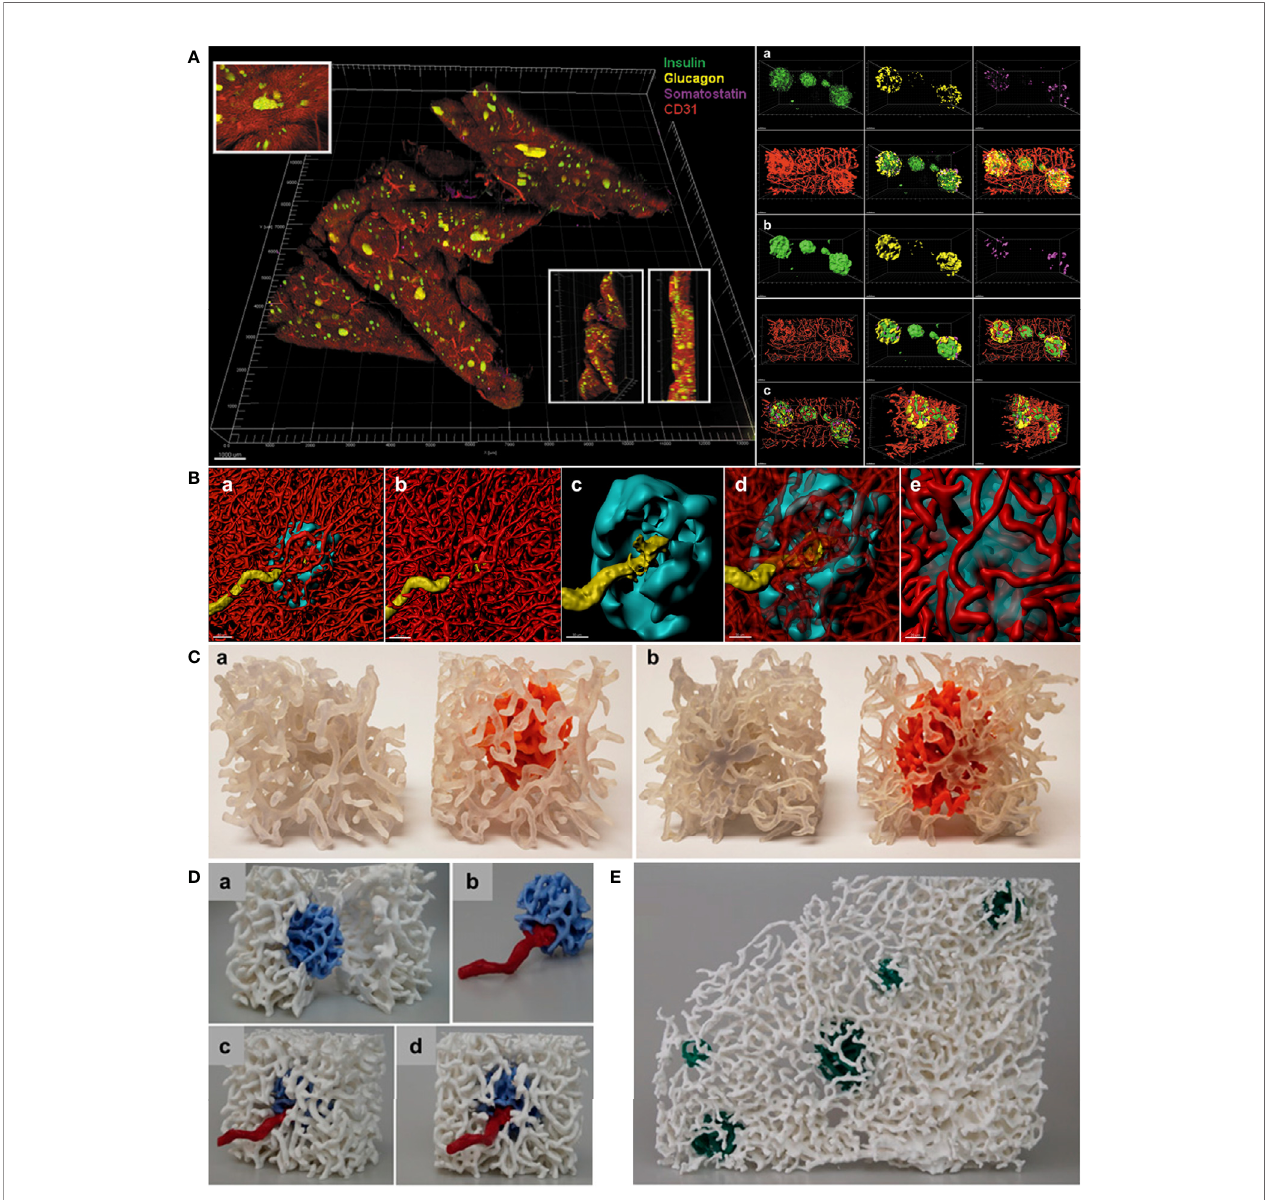
FIGURE 2 | In situ approach to study the capillary network. (A) Left . Full scan of a 600 µm pancreatic slice immunostained for insulin (green), glucagon (yellow), somatostatin (magenta) and CD31 (red). Three insets for detailed islet resolution and displaying depth with different angles. Scale bar: 1000 µm. Right . a. Cluster of islets in the sample with individual fl uorescent channel images and merged ones. b. Same cluster of islets converted to a computer-generated surface rendering with multiple angles displayed for 3D viewing. c. Coronal slice of all islets in the cluster and a sagittal slice of the leftmost islet visualized by use of a computer-generated clipping plane to reveal the intraislet blood vessels. Scale bars: all 50 µm. (Adopted from 25) (B) a. 3D-rendered view of a human islet integrated in the pancreatic capillary network. Islet (HPi1, a human pan-endocrine cell marker in cyan), blood vessels (CD31 in red), and an afferent arteriole ( a - SMA in yellow). Scale bar: 50 µm. b. Blood vessels only, displaying the continuity of capillaries in the islet as well as exocrine tissue. c. The aforementioned feeding arteriole penetrating the center of the islet. Scale bar: 30 µm. d. Vasculature partially made transparent. e. Close-up view of the interface of capillaries entering and exiting the islet. Scale bar: 20 µm. (C) 3D prints of a human islet. a. Side-by-side comparison of the same region of pancreas with exocrine and endocrine (intraislet) capillaries printed the same color (left, clear) and the exocrine capillaries in clear and endocrine capillaries in orange (right). b. Opposite side. (D) A more expansive view of the endocrine/exocrine vascular network with feeding arteriole shown in (B) Blood vessels within the islet (light blue) are integrated with those in the exocrine tissue (white). A feeding arteriole (red) penetrates the center of the islet. a. A cross-sectional view of the islet capillary network within the exocrine tissue vasculature. b. Islet capillaries with a feeding arteriole. Note the markedly larger size of the feeding arteriole compared with endocrine blood vessels. c. Side view of the endocrine and exocrine vascular network. d. Front view of the endocrine and exocrine vascular network. (E) Human islet vascular network embedded in the exocrine vasculature. Blood vessels in fi ve human islets (dark green) integrated with the pancreatic vascular network (white). ( B – D , adopted from